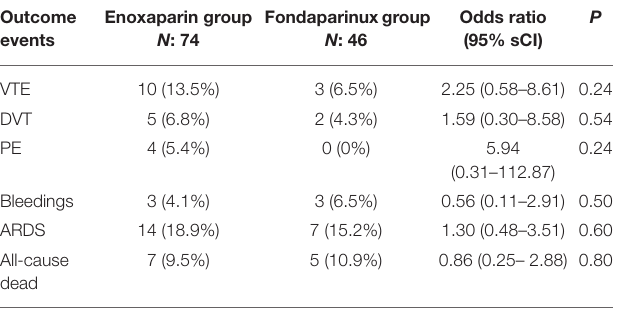
TABLE 2 | Incidence and regression model for the risk of outcome events according to different VTE prophylaxis drugs. Outcome